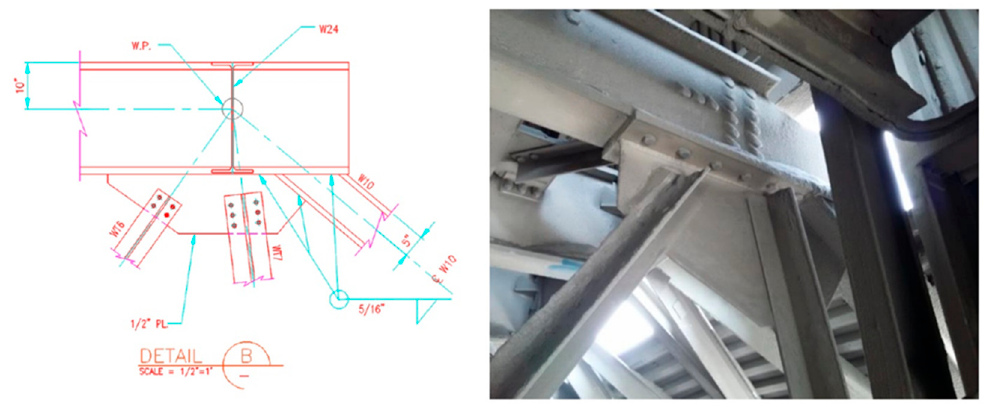
Figure 1. The shape of the gusset plate and the connection type (weld instead of bolts) do not match the documentation.